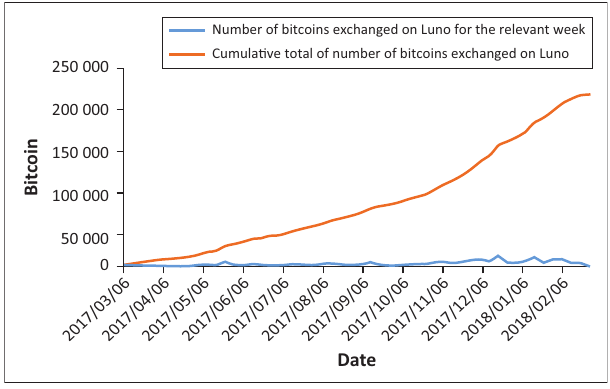
FIGURE 1: The number of bitcoins exchanged for South African rand on Luno for the period 01 March 2017 to 28 February